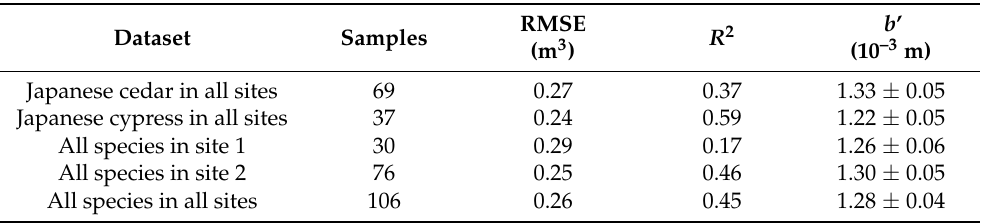
Figure 7. Comparison between the reference tree volume and those estimated using the tree biomass estimation model applying the pipe model theory. ( a ) and ( b ) are Japanese cedar and Japanese cypress in all sites, respectively. ( c ) and ( d ) are all species in sites 1 and 2, respectively. ( e ) is all species in all sites. Table 1. Accuracy of tree stem volume estimation using the tree biomass estimation model applying the pipe model